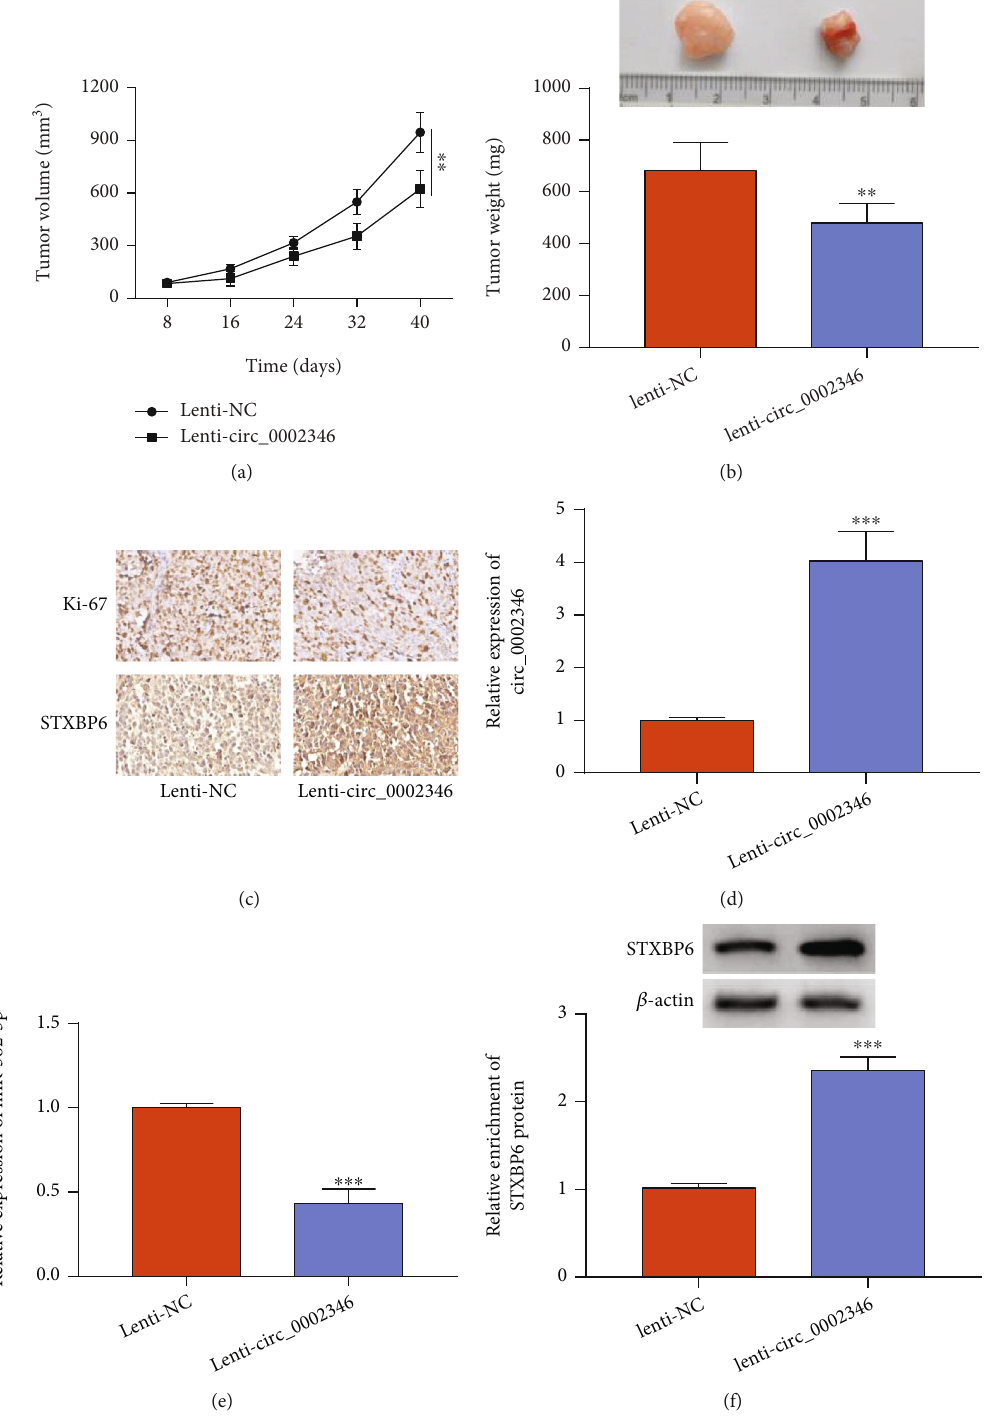
Figure 7: circ_0002346 overexpression suppresses xenograft tumor growth in vivo . (a) Tumor volume was monitored every 8d for 40 d as length × width 2 × 0 : 5 . (b) Tumor weight was recorded after inoculation for 40d. (c) An IHC assay was conducted to analyze the protein levels of Ki-67 and STXBP6 in tumor tissues. (d, e) RT-qPCR was conducted to measure the levels of circ_0002346 and miR-582-3p in tumor tissues. (f) A Western blot assay was performed to detect the protein level of STXBP6 in tumor tissues. ∗∗ P < 0 : 01 ; ∗∗∗ P < 0 : 001